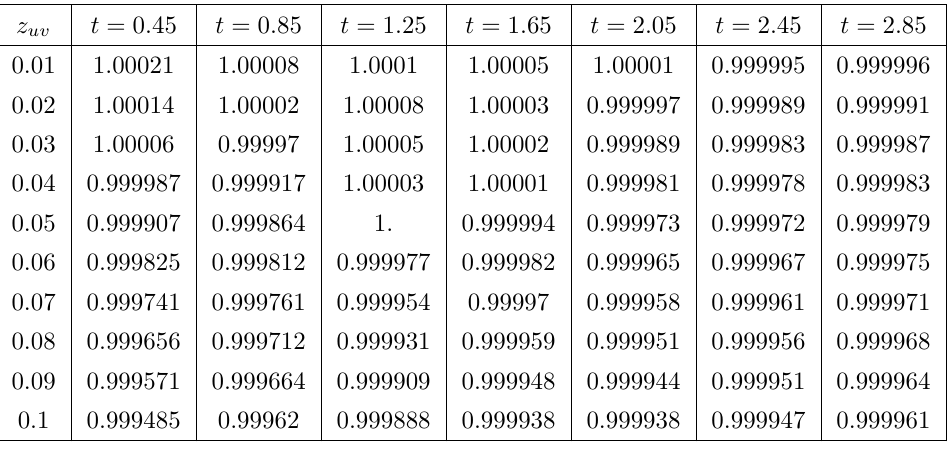
Table 12 . We vary our cuto(cid:11) from .01 to .1 and (cid:12)nd stable results of the correlation functions on the order of 10 (cid:0) 5 . These values were calculated for 2-point correlation functions of an (uncharged) scalar operator in a charged thermalizing (cid:13)uid (dual to the evolution towards a charged magnetic black brane geometry), (cid:26) = 0 : 78 (cid:26) e , B = 1 : 0 and boundary conditions l = 0 : 5. Our numerical background geometry was computed with a grid size of 105 points in the radial direction and a grid size of 250 points for our non-a(cid:14)ne parameter. Constraint κ ( t ) :Thermalizing plasma in an external magnetic field